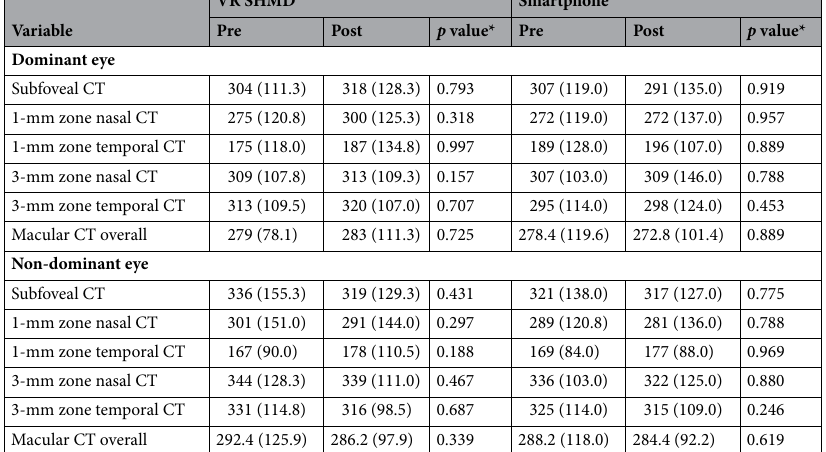
Table 2. Changes in choroidal thickness after playing games on a virtual reality smartphone-based head- mounted display (VR SHMD) or smartphone. Data presented as the median (interquartile range) unless otherwise indicated. CT, choroidal thickness. *Wilcoxon-signed rank test and adjusted using the Benjamini– Hochberg procedure.